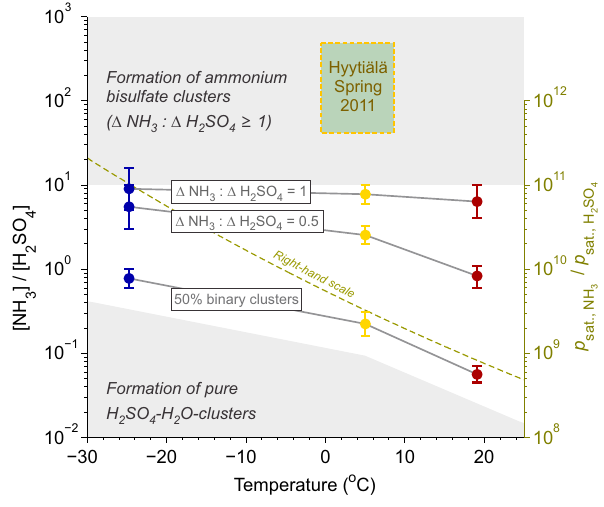
Figure 7. Summary of the observed composition of (NH 3 ) m · (H 2 SO 4 ) n · HSO − anion clusters for the covered 4 experimental conditions: varying vapor concentration ratios [NH 3 ]/[H 2 SO 4 ] (left vertical axis) and temperatures (horizontal axis and same color scale as for Fig. 6). Three specific features of cluster composition are presented at three investigated temperatures each, by a total of nine circles. These three features are (1) a fraction of 50% of pure, NH 3 -free sulfuric acid clusters, (2) a ratio of added NH 3 molecules per added H 2 SO 4 molecule, (cid:49)m/(cid:49)n , = 0.5, and (3) (cid:49)m/(cid:49)n = 1. Values and uncertainties are based on the data shown in Fig. 6. Consequently, the grey shaded area at the bottom covers conditions allowing the formation of pure binary (NH 3 -free) H 2 O–H 2 SO 4 clusters. The grey shaded area at the top covers conditions that allow for the formation of clusters with about equal numbers of NH 3 and H 2 SO 4 molecules (as in ammonium bisulfate). The position of the green box and the color of its dashed edge line mark the conditions during the measurements in the boreal forest (Hyytiälä). Shown in brown (right vertical axis and line) is the ratio of saturation vapor pressures of NH 3 and H 2 SO 4 ( p sat. , NH / p sat. , H 3 2 SO 4